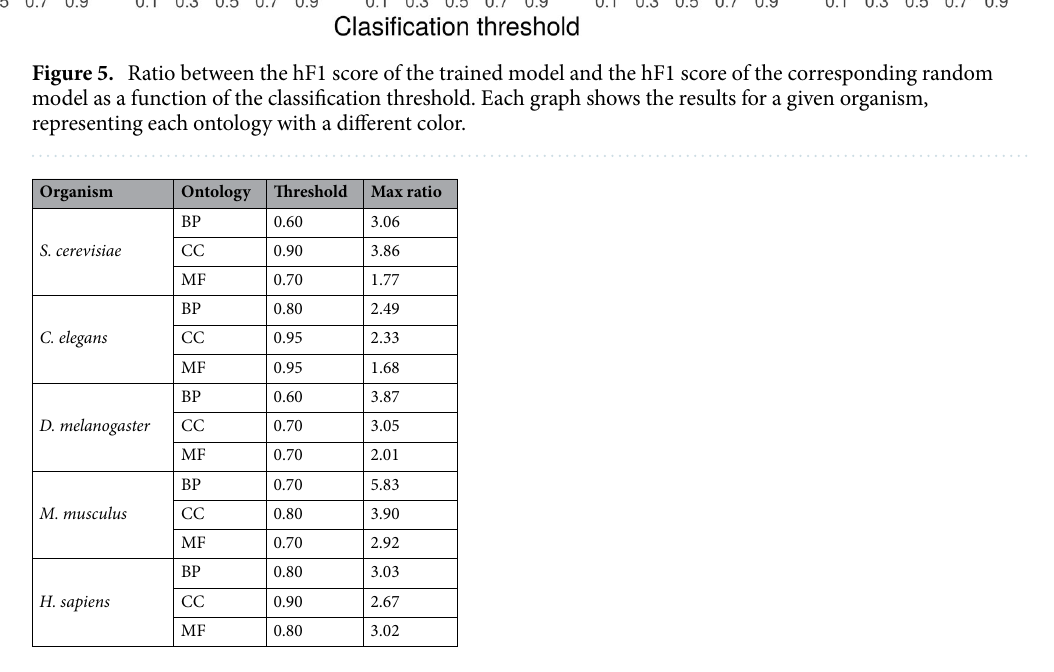
Table 2. Max ratio between the hF1 reached by the trained model and the corresponding hF1 reached by the random model over the set E for each possible pair organism/ontology.